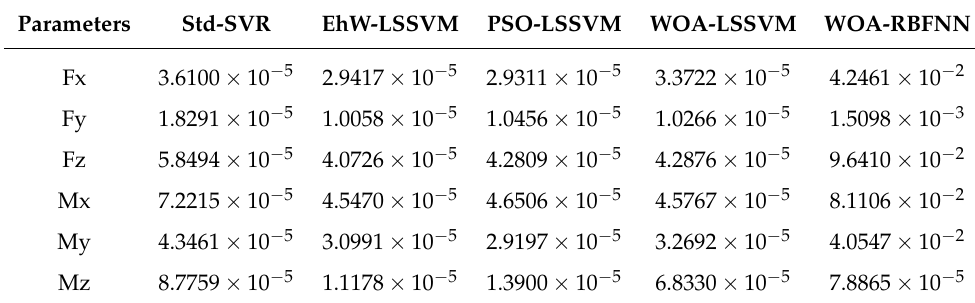
Table 4. Compensation results on the testing set by different